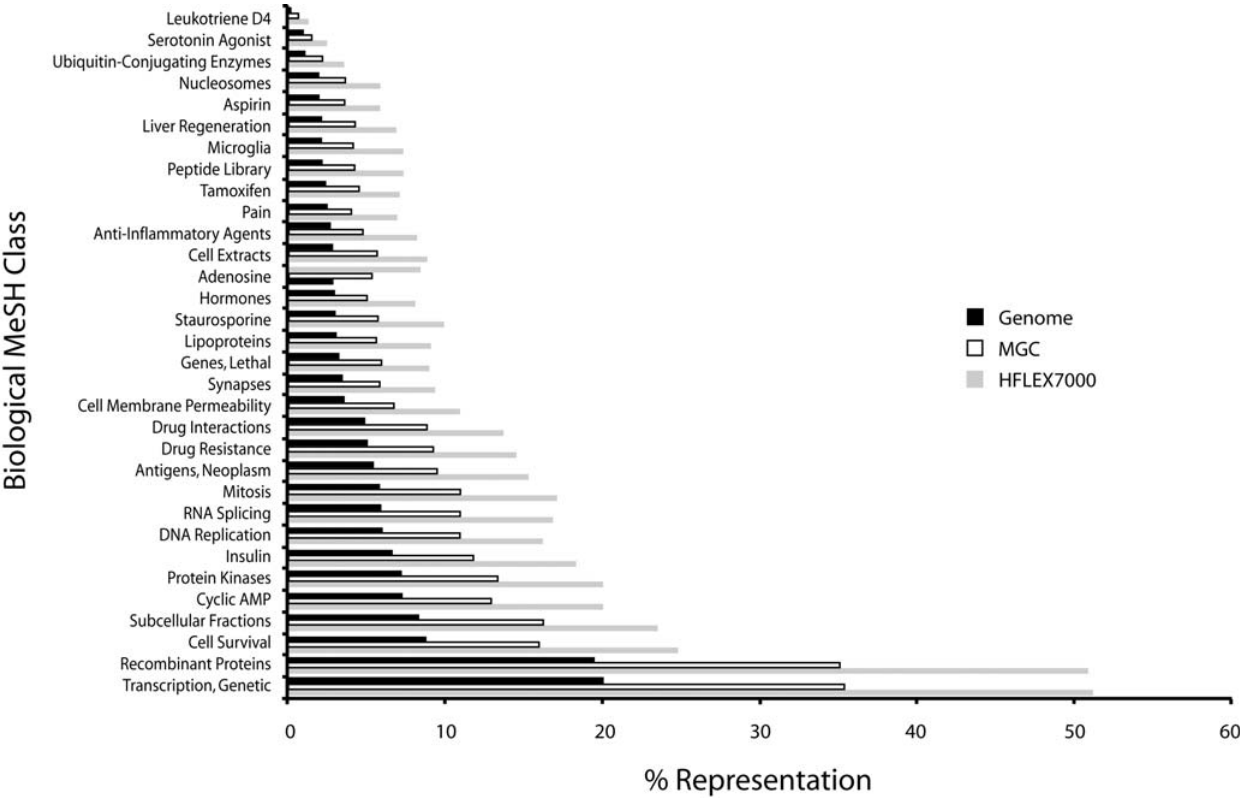
Figure 2. Genes associated with Biological MeSH Terms in Publications. The clone target list (HFLEX7000) was compared with all human genes (EntrezGene, 2004) and all genes represented by MGC (2004) with respect to published relationships of the genes to all biological MeSH terms and MeSH nodes (34). The targeted genes reveal similar proportionality to the other gene lists but a general enrichment of genes related to MeSH terms (Table 2; Supplementary Table